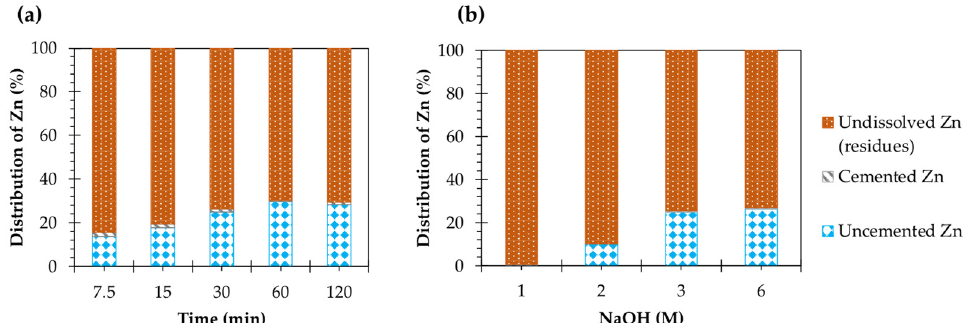
Figure 5. Effects of ( a ) leaching time and ( b ) NaOH concentration on cementation and distribution of Zn in leaching pulp when Al powder was added during ZPLR leaching (for interpretation of the references to color in this figure legend, the reader is referred to the web version of this article).